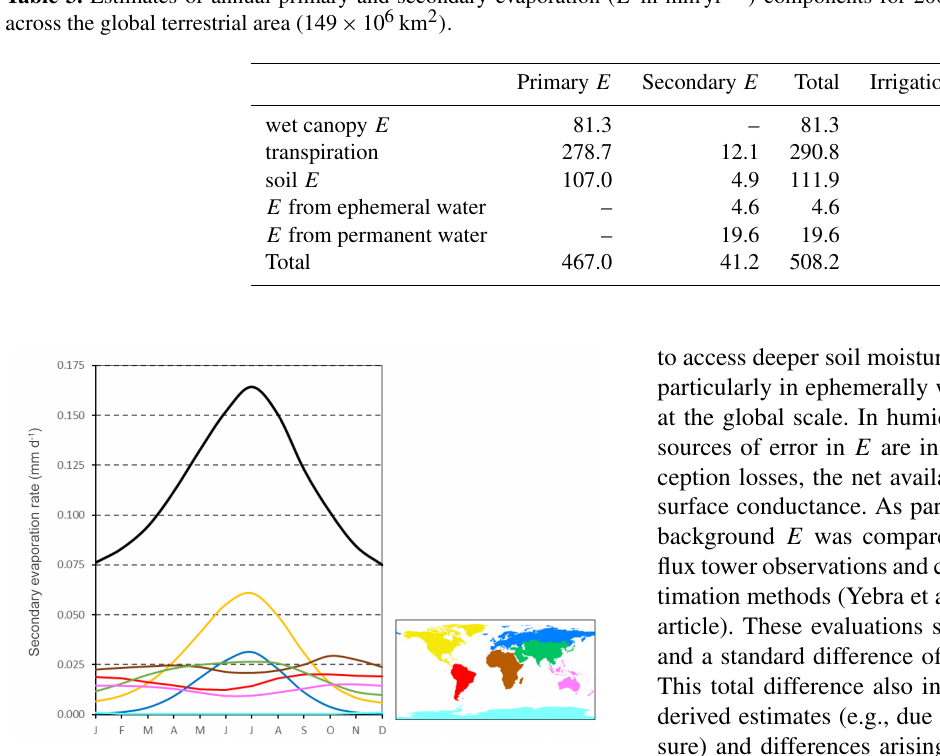
Figure 11. Average (2001–2012) seasonal cycle of secondary evap- oration at the global scale (black line) and the contribution from different regions (colours corresponding to the map). All rates are expressed in mmd − 1 for the global land